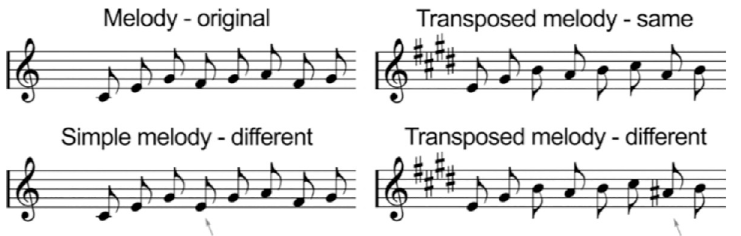
Fig 1. Examples of stimuli from the c-MDT Simple Melodies (L) and Transposed Melodies (R). Children listen to two melodies and decide whether the second was the same or different. Arrows represent the ‘different’ note. Figure adapted from [21].